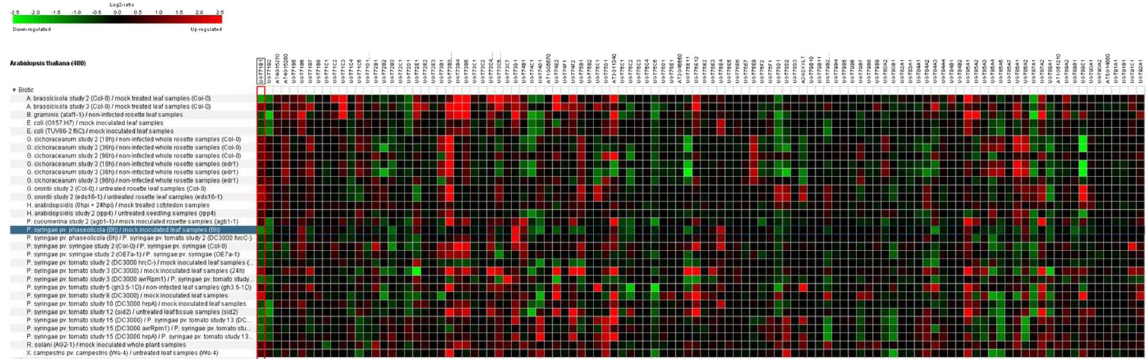
Figure 1. Differential expression of up and downregulated UGTs of Arabidopsis in response to different pathogen infestations ( A . brassiciola , B . graminis , E . coli , G . cichoracearum , G . orontii , H . arabidopsidis , P . cuccumerina , P . syringae , R . solani , and X . campestris ). Green color is showing down regulated UGTs and red color is showing up regulated